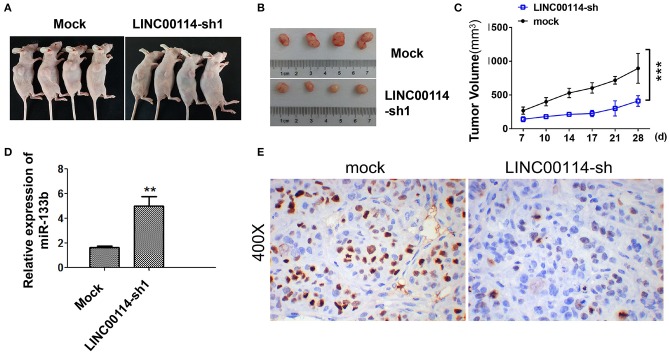
LINC00114 interference inhibits the development of CRC in vivo. (A) Tumor formation in nude mice. (B) Tumor body in nude mice. (C) Tumor growth curve. (D) Expression of miR-133b in tumor tissues. (E) Ki67 expression determined by immunohistochemistry. **P < 0.01; ***P < 0.001.